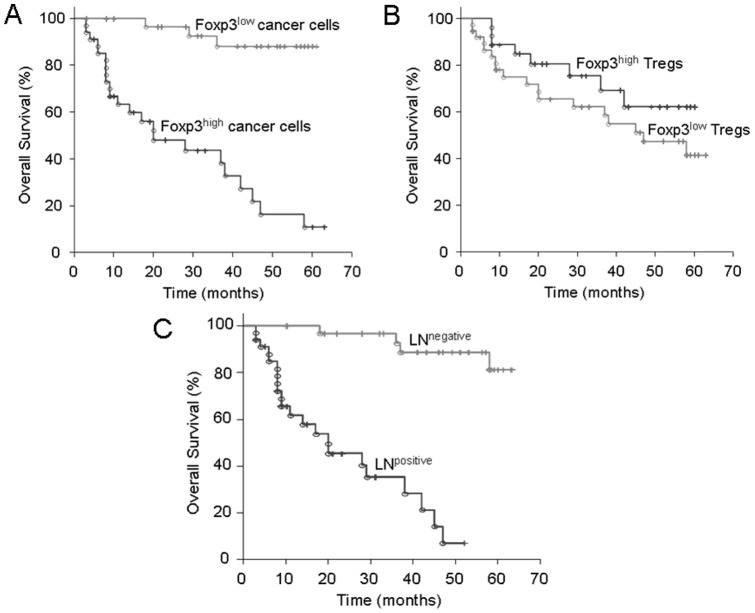
Overall survival of cancer patients with Foxp3+ cancer cell expression in their CRCs compared with the overall survival of those with infiltrated Foxp3+ Treg in their tumors.(A) Patients with high Foxp3+ cancer cell expression (>16%, as mean cut-off) had a poorer prognosis than those with low Foxp3+ cancer cell expression profiles (<16%; mean cut-off: 16%), (p<0.001, Log-Rank test). (B) No significant difference in the overall survival comparing patients with low and high Foxp3+ Treg expression profiles (mean cut-off: 12%), (p = 0.202, Log-Rank test). (C) Patients with lymph node metastasis had a poorer prognosis than those without lymph node metastasis (p<0.001, Log-Rank test). The times of the censored data are indicated by short vertical lines.